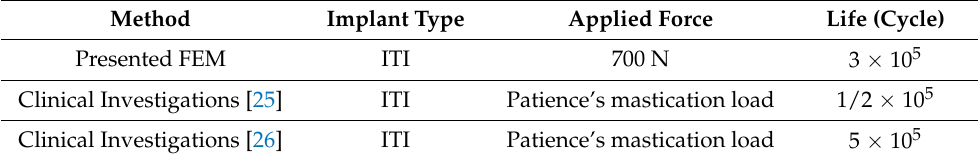
Table 5. A comparison between the results obtained from theories with the clinical data.